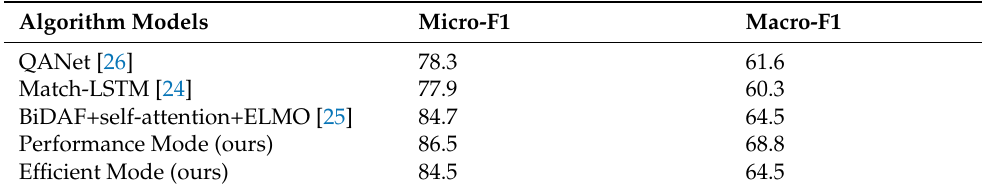
Table 2. Superimposed experiments based on CAIL2018. Algorithm